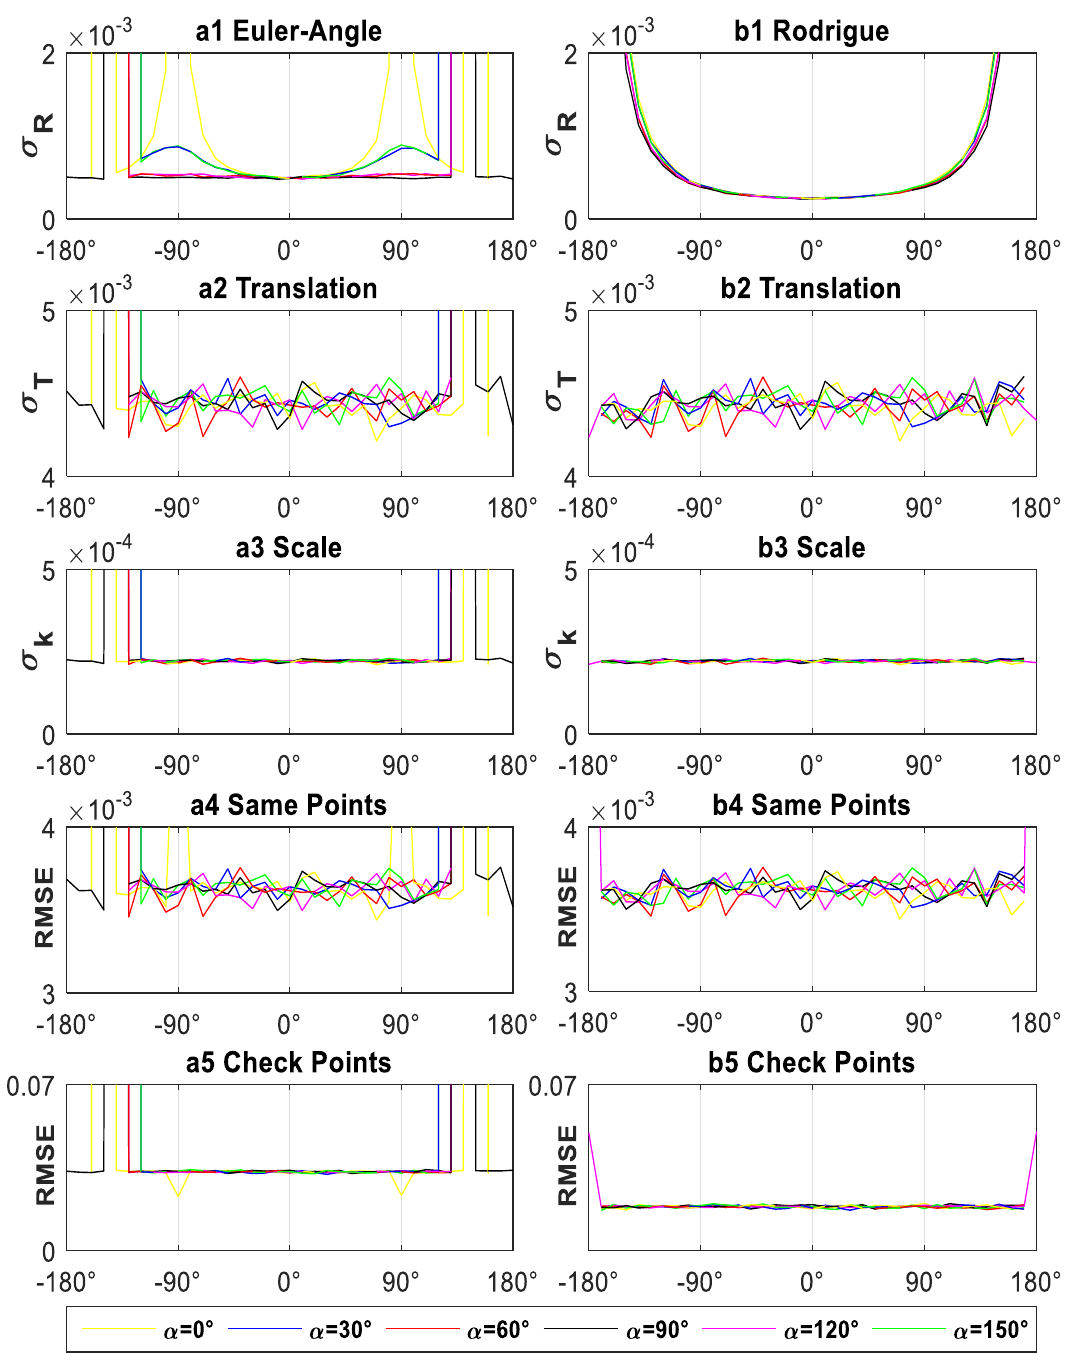
Figure 1. Transformation precision of the current transformation model for experiment I (each x axis value represents a different rotation angle, each y axis value represents a different precision for a different precision index ( a1 )-(rad), ( b1 )-(a.u.), (m), (a.u.), RMSE(m)), each color represents a different rotation axis for different, ( a1 – a5 ) shows the results of the EA-Method, subgraph ( b1 – b5 ) shows the results of the R-Method).